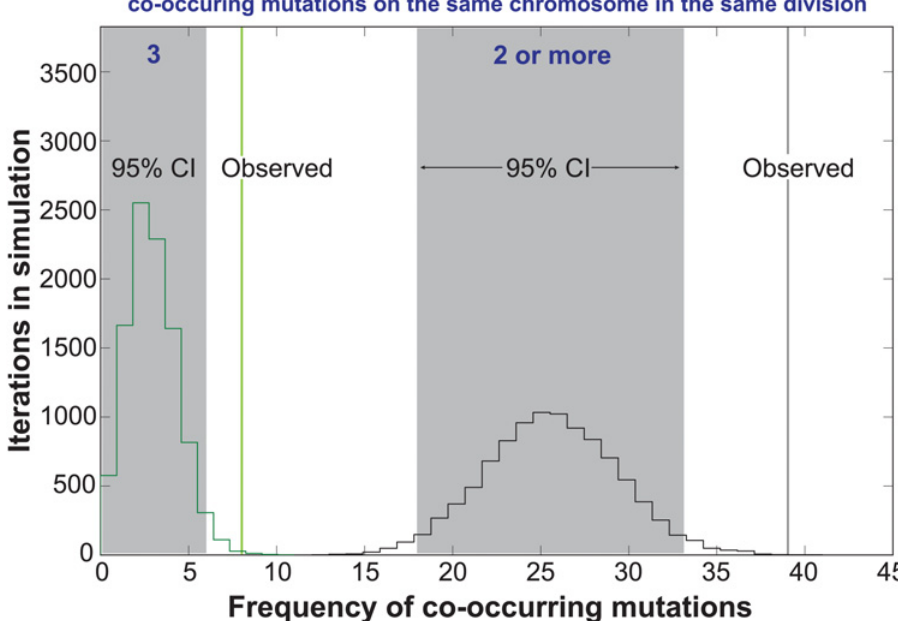
Fig 3. Co-occurrences of mutations in the same chromosome and cell division. The random accumulation of 237 mutations over 87 cell divisions was simulated using 10,000 iterations. green histogram, co-occurrences in the simulation with 3 mutations on the same chromosome; green vertical line, actual co- occurrences with 3 mutations; black histogram, co-occurrences with 2 or more mutations on the same chromosome; gray shading, 95% confidence intervals; black vertical line, actual co-occurrences with 2 or more mutations.